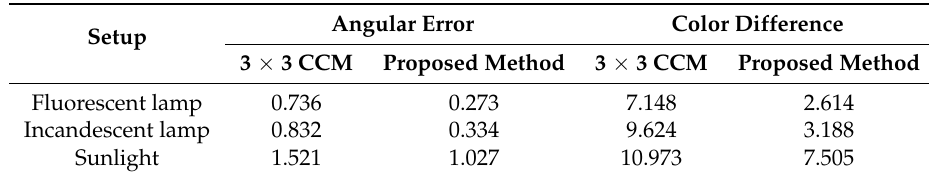
Figure 13. Performance measurement graph for color patches of GretagMacbeth ColorChecker SG. The red bar indicates performance of proposed method: ( a ) Angular error; ( b ) Delta E; and ( c ) Numbering of patches. Table 2. Average angular error and ∆ E